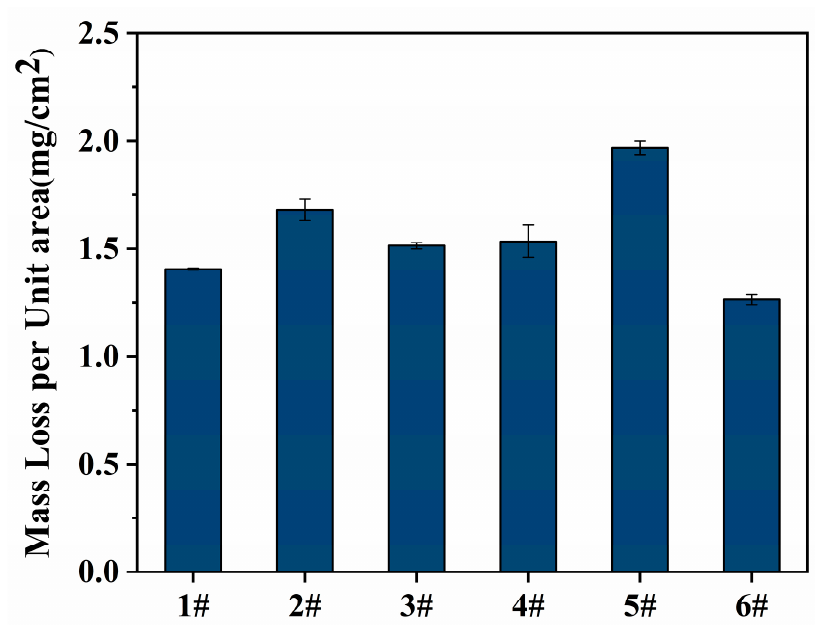
Figure 12. The nitric acid mass loss test (NAMLT) test results of cold rolled alloys.